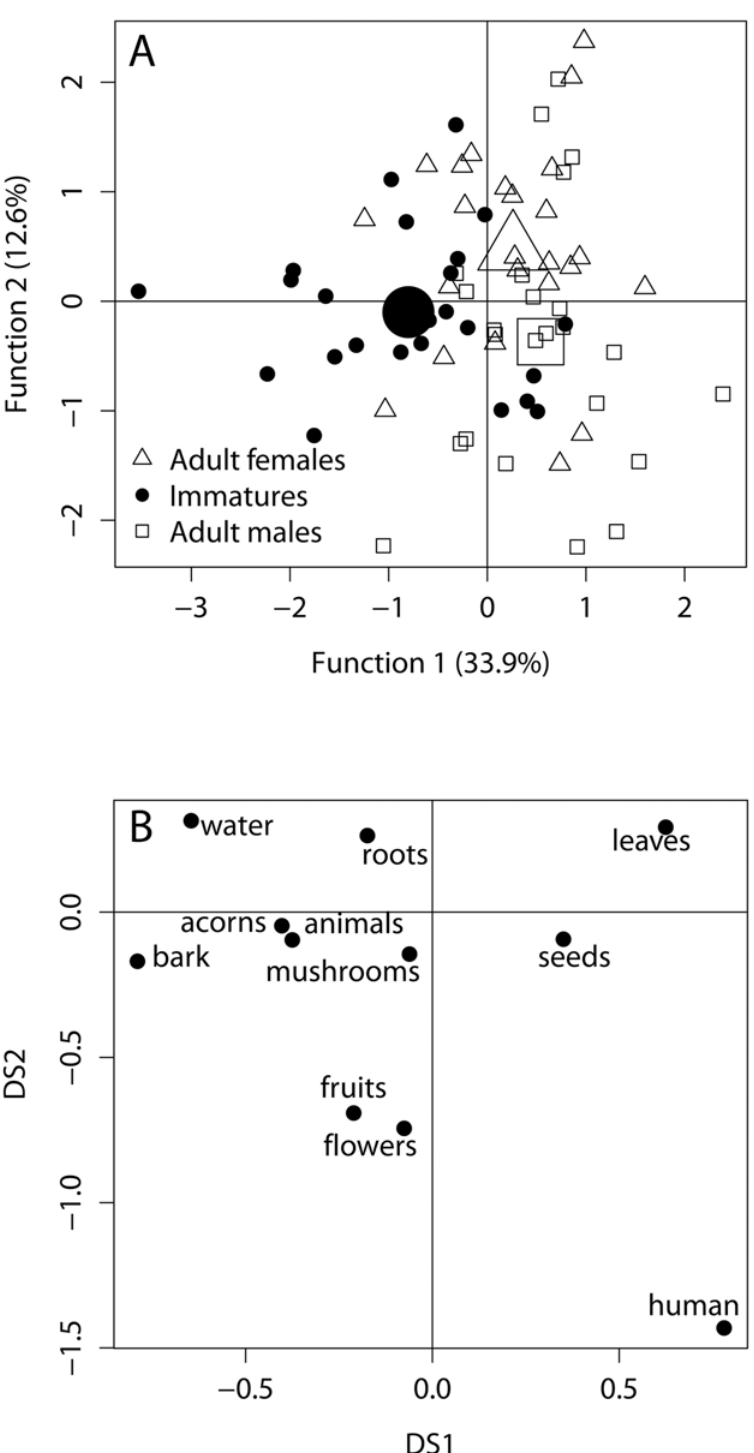
Fig 7. Scatter plots of the discriminant function analysis among three age-sex categories of individuals. A: Scatter plot of two discrimination functions based on samples from adult males, adult females and immatures. The largest symbols indicate the mean of the cloud for each age-sex category; B: Scatter plot of the canonical weight of the discriminant analysis. Variables are the 11 food categories of macaques ’ diets.